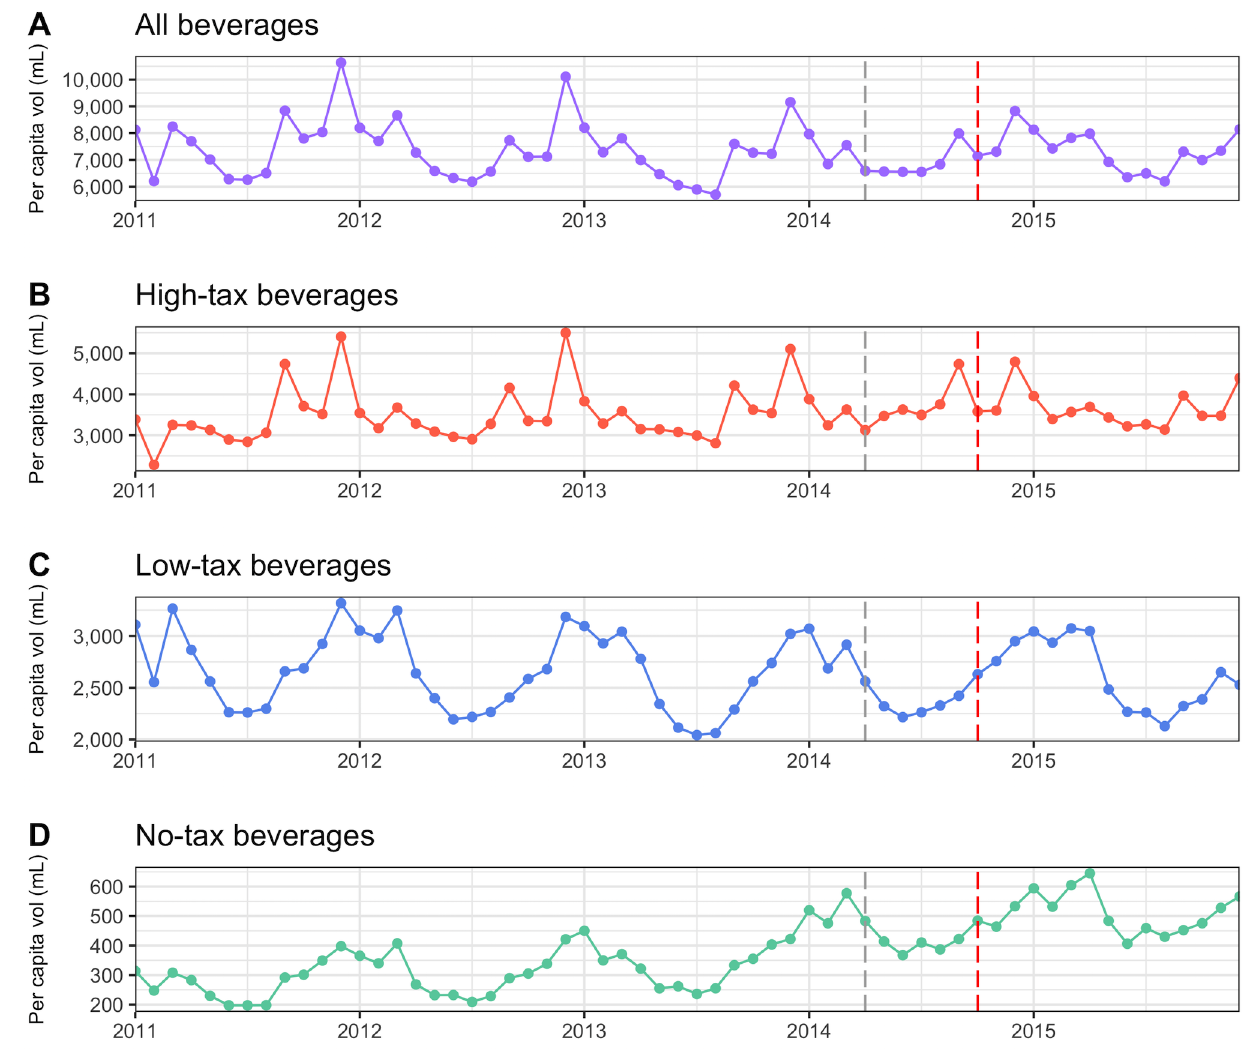
Fig 1. Volume (mL) of soft drink products purchased from January 2011 to December 2015. (A) All beverages, (B) high-tax products, (C) low-tax category, (D) no-tax category. Aggregated mean volume of soft drinks purchased from January 2011 to December 2015. The grey vertical dotted line in the figure refers to the announcement of the IABA tax policy in March 2014, whereas the red vertical dotted line is for the implementation of the policy in October 2014. Source: authors’ analysis of the Kantar WorldPanel data for urban households in Chile. IABA, Impuesto Adicional a las Bebidas